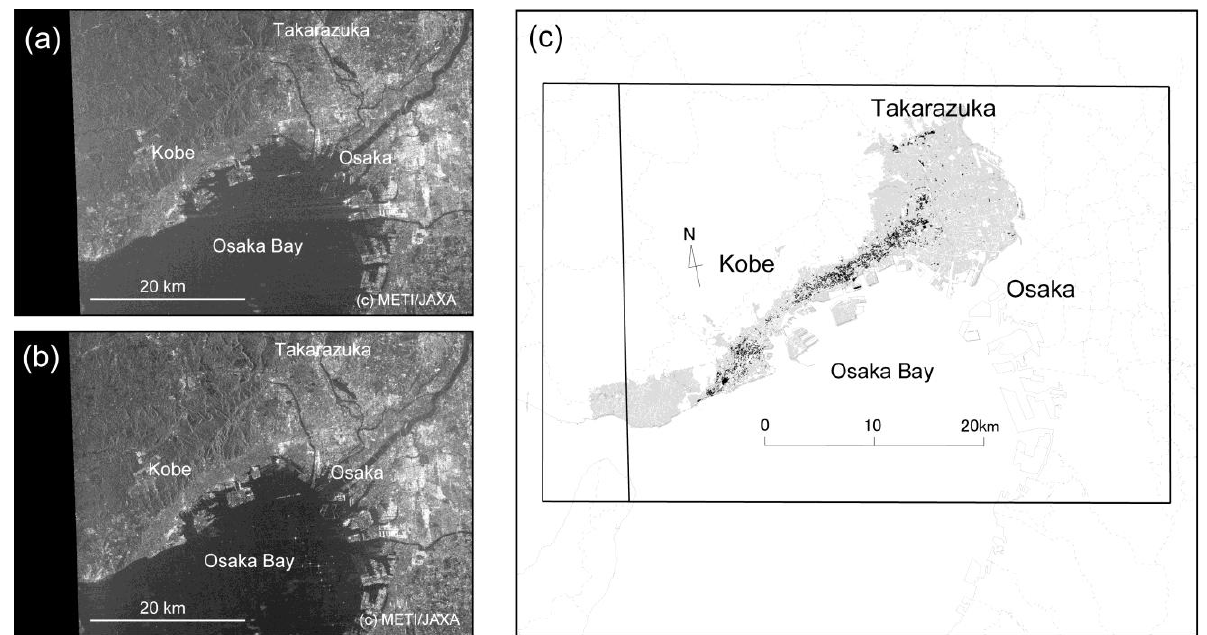
Figure 1. JERS-1/SAR images from before and after the 1995 Kobe earthquake and target area of analysis. (a) Image taken May 17, 1994 (before). (b) Image taken May 4, 1995 (after). (c) Building damage data after the earthquake (black areas indicate severe damage ratio of over 30%)